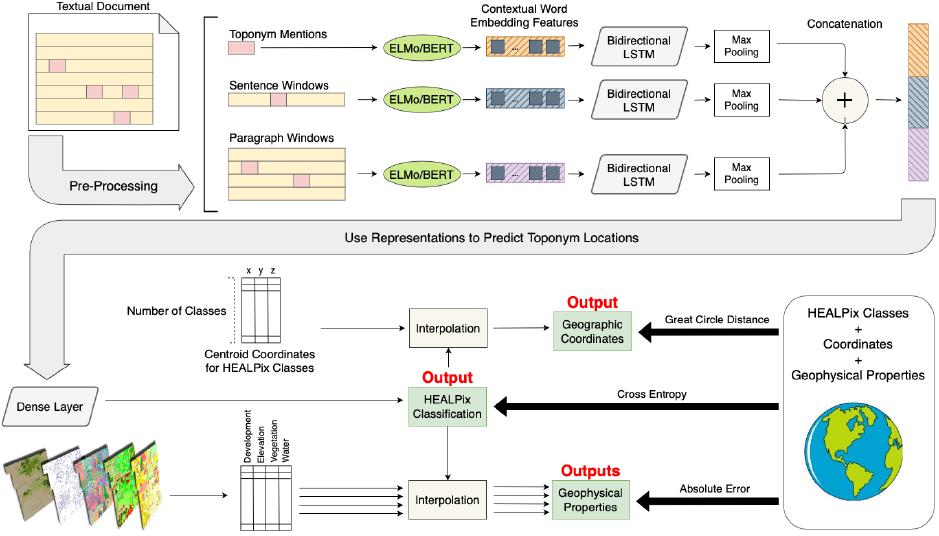
Figure 2. Overall workflow for the proposed toponym resolution